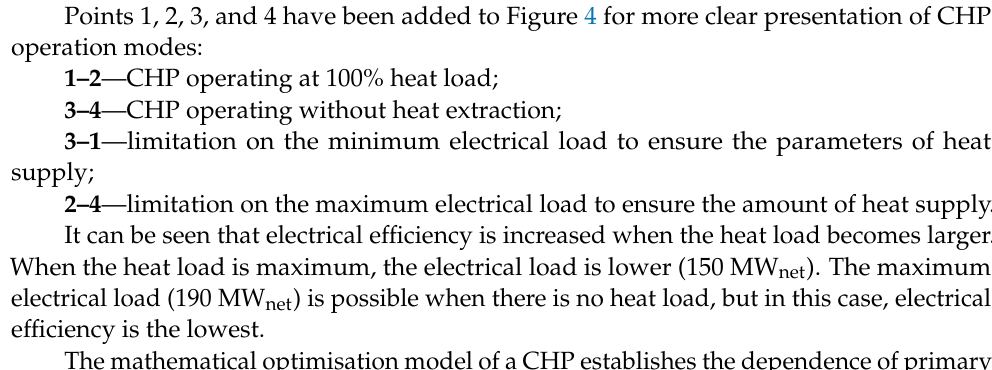
Figure 4. Electrical efficiency of the CHP unit based on the heat load.